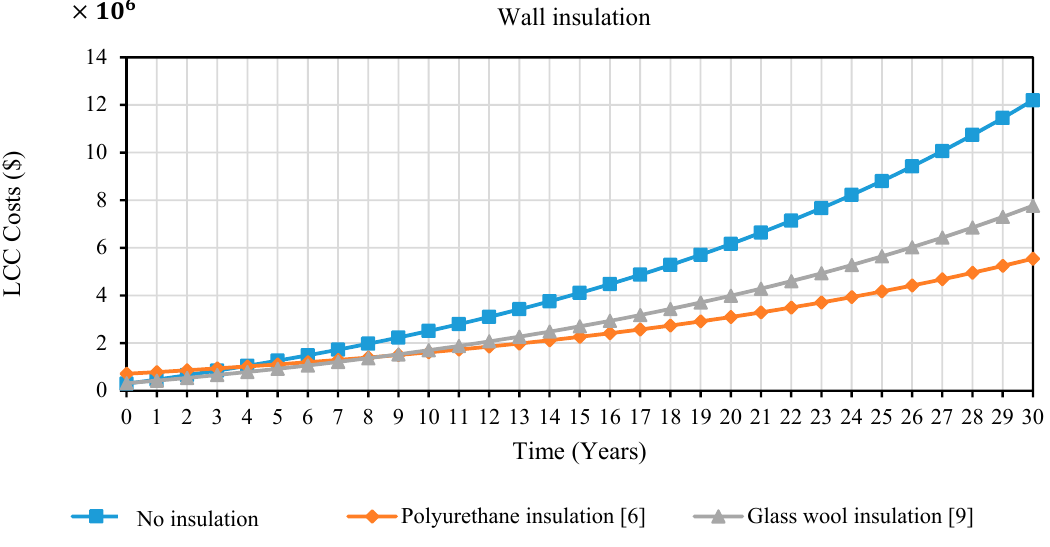
Figure 21. Comparison of the life cycle cost (LCC) for the insulation scenarios number 6 and 9 based on Table 5.